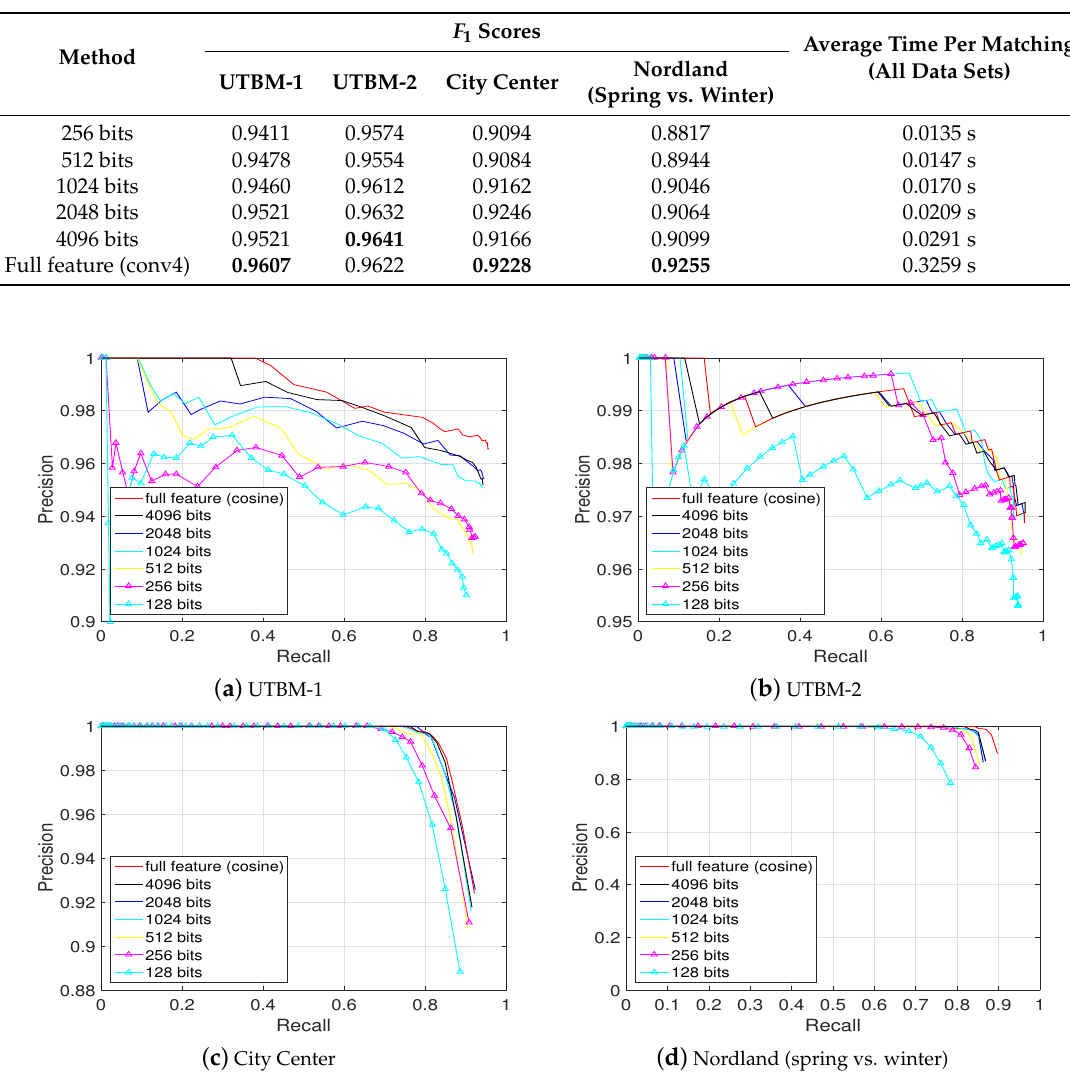
Table 4. F 1 -scores and matching time comparison of different lengths of hash bits. For each data set, the highest F 1 -Score is bold.